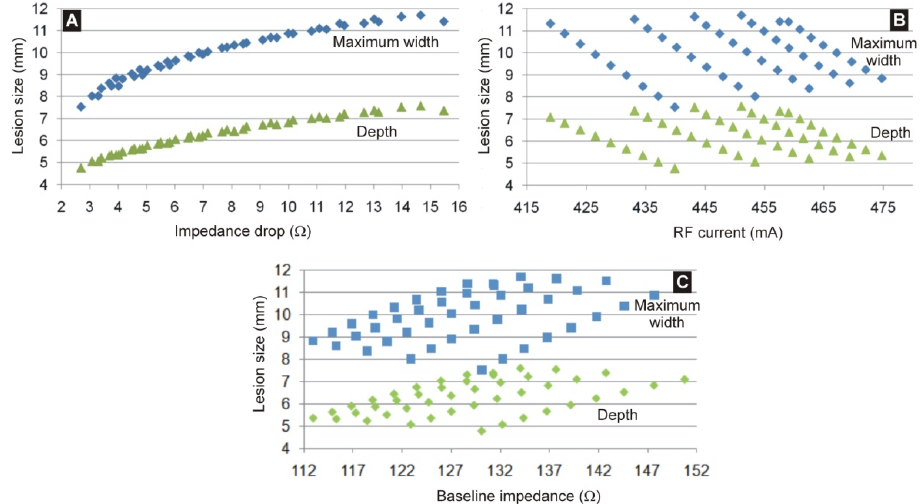
Figure 6. Relationship between lesion size (depth and maximum width) and impedance drop ( A ), total current delivered at 15 s ( B ) and baseline impedance ( C ).